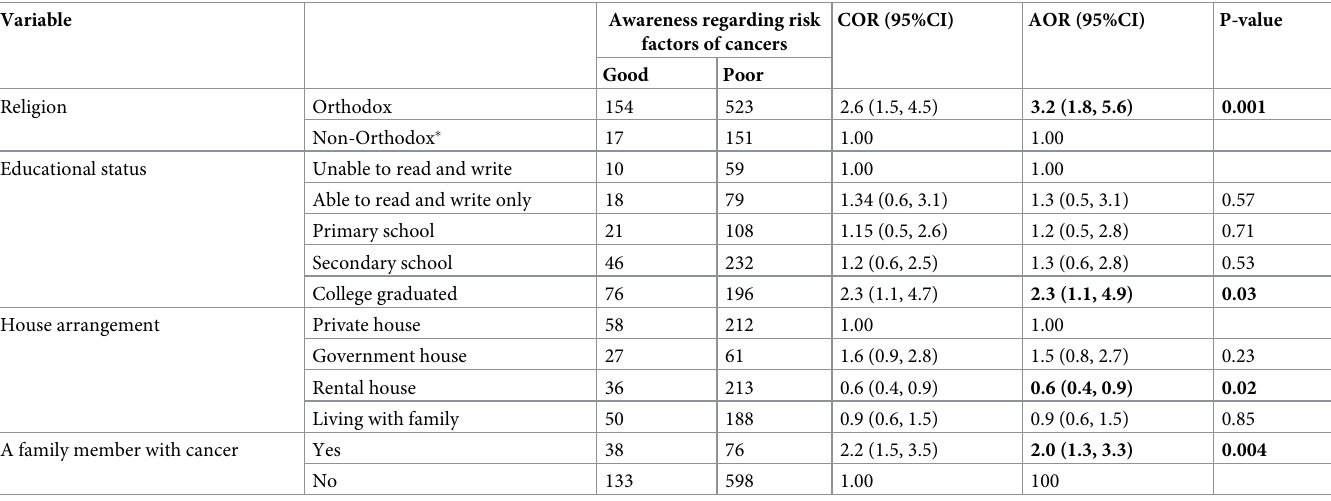
Table 3. Simple logistic regression analysis on factors of awareness regarding risk factors of cancers in Bahir Dar city residents, northwest Ethiopia, 2019 (n = 845).